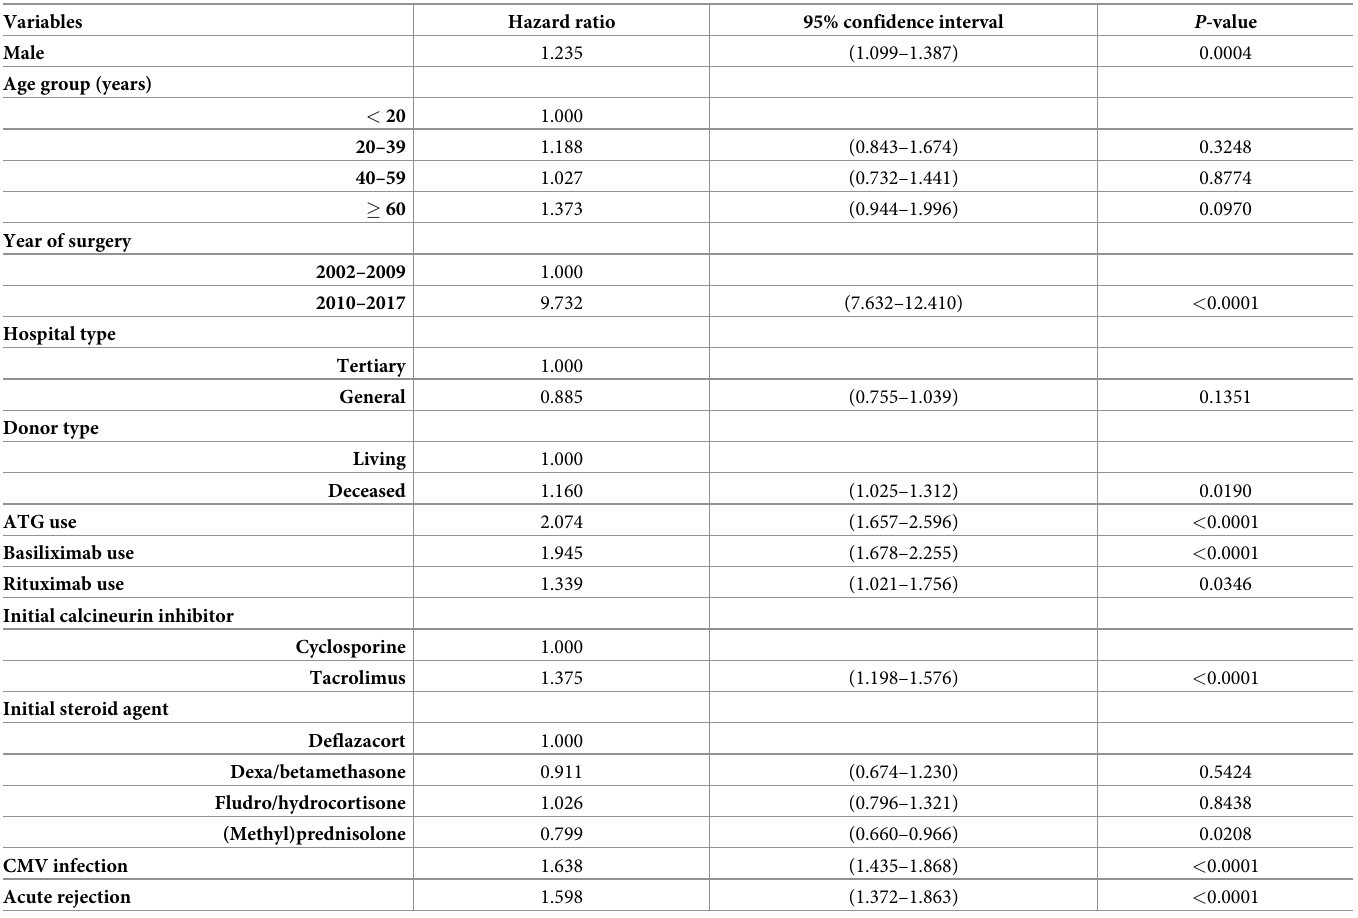
Table 5. Multivariate Cox-proportional hazard model for risk factor of graft